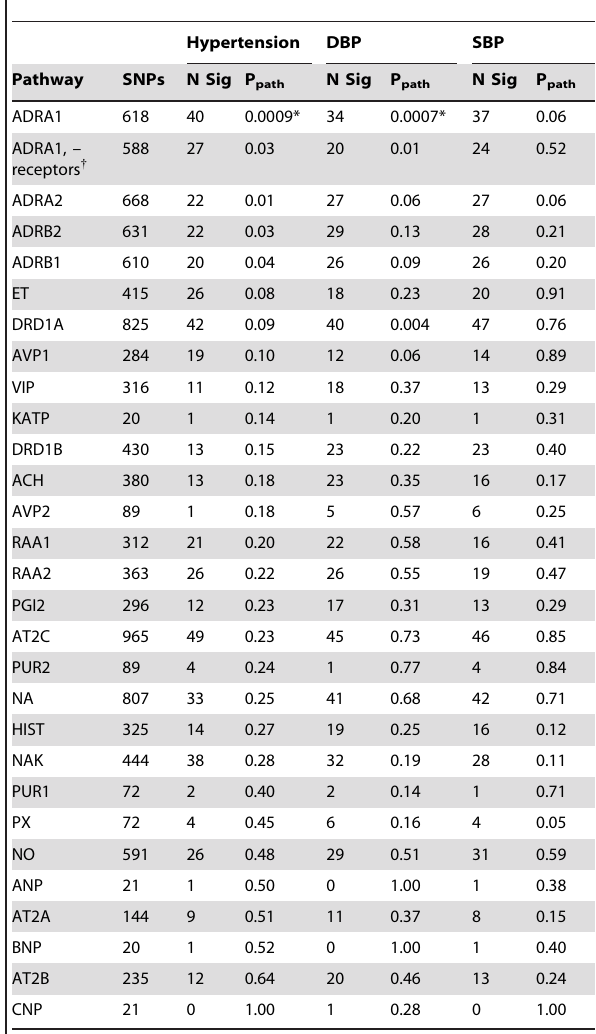
*p-value is significant after correction for multiple testing. { ADRA1, -receptors is the same pathway as ADRA1, with the ADRA1 receptor genes removed from the model. Adjustment was made for sex, age, age 2 and BMI for all